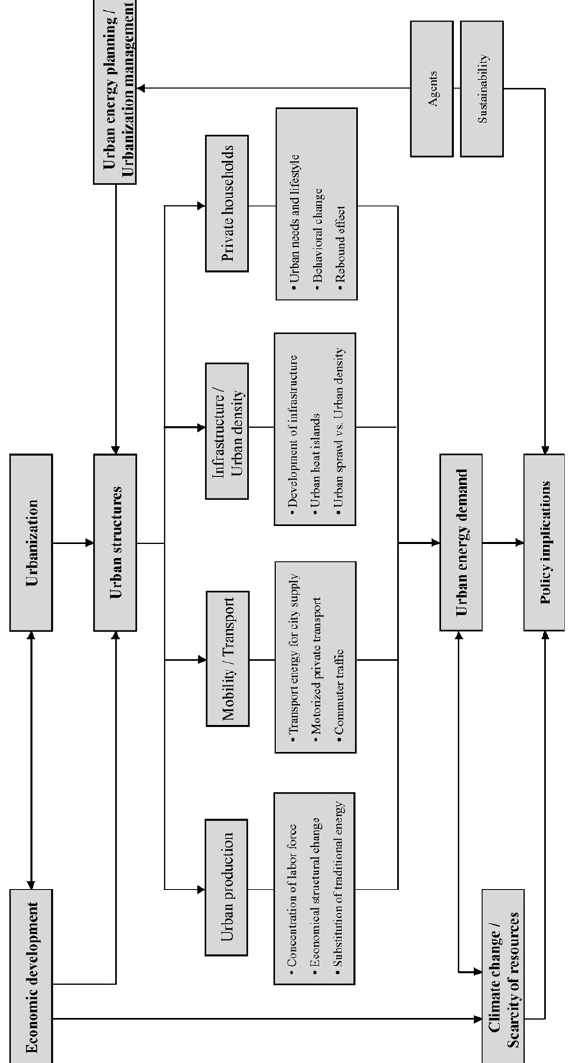
Figure 1. Impacts of urbanization on urban structures and energy demand (taken from Madlener and Sunak (2011)) They conclude with “In order to manage urbanization and to mitigate increasing energy demand in developing countries, particularly with regard to emerging megacities and the tendency of ‘overurbanization’, policy measures have to be multidimensional, participatory, and multi-sectoral.” (Madlener and Sunak (2011). However, they lack of a modeling